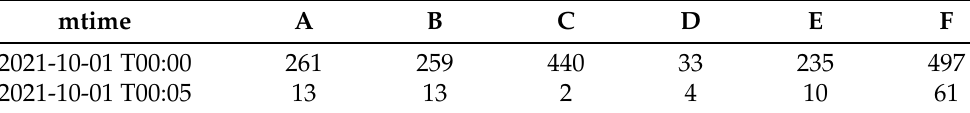
Table 3. Partial data from the Huawei Software Elite Challenge